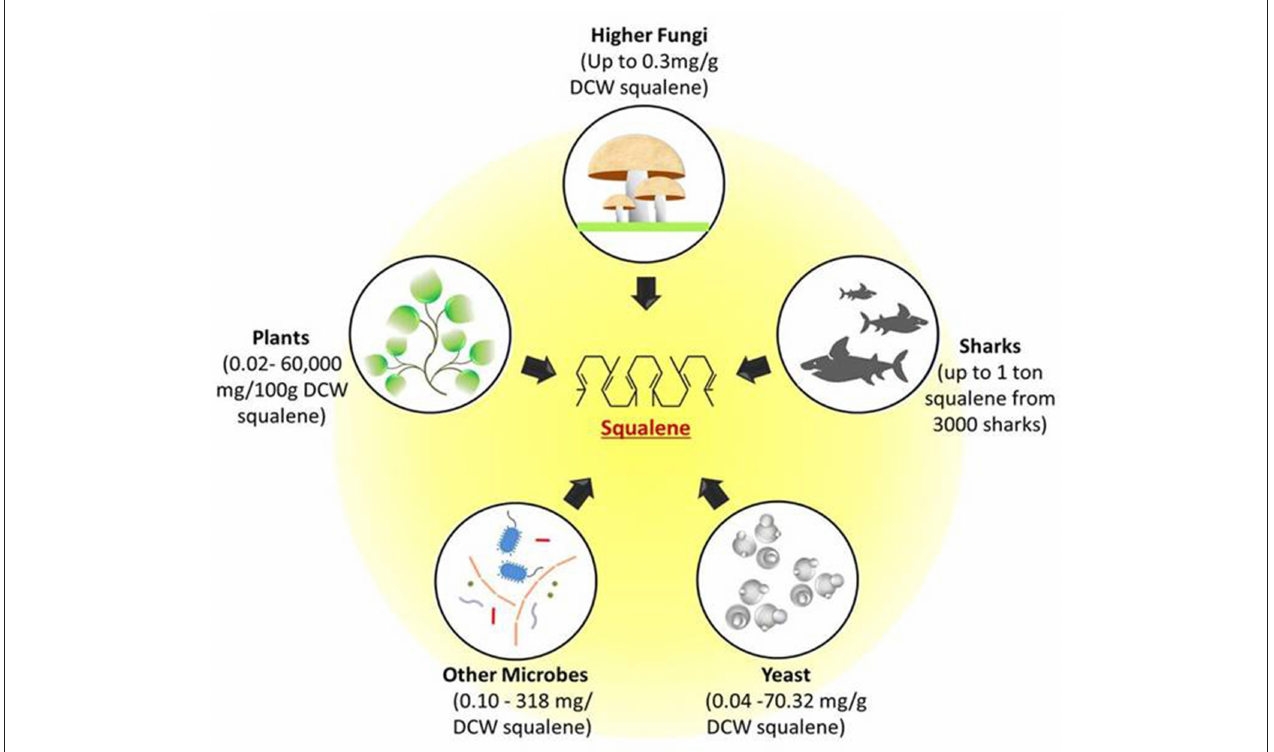
FIGURE 1 | Potential natural sources of squalene. Figure depicts the possible squalene sources ranging from unicellular microbes such as yeast and other bacterial cells to multicellular fungi, plants, and deep sea sharks. All these sources can produce squalene through mevalonate pathway. DCW, Dry cell